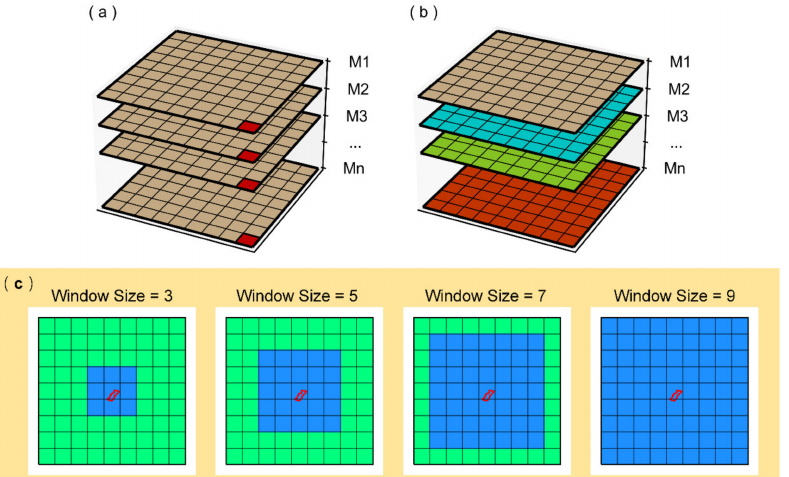
Figure 1. Establish TWSA downscaling models ( a ) in the temporal dimension and ( b ) in the spatial dimension; M1, M2, . . . , Mn represent the monthly resolution grid data used to establish the downscaling model. ( c ) Set up of the modeling window, the green grid represents the study area; the blue grid represents the modeling